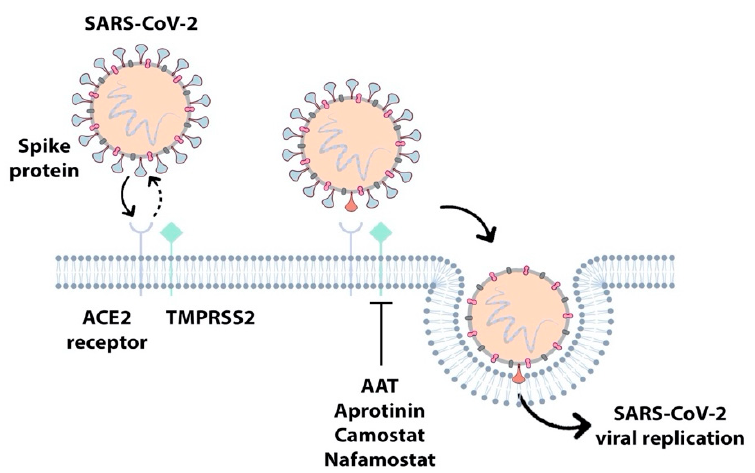
Figure 6. Host proteases are necessary for SARS-CoV-2 viral infectivity. SARS-CoV-2 uses the host angiotensin-converting enzyme 2 (ACE2) as an entry receptor. The TLP TMPRSS2 then cleaves and activates the spike protein of the virus, which mediates cell entry, viral replication and infectivity. A number of endogenous (AAT) and exogenous, large (aprotinin) and small molecule (camostat and nafamostat), inhibitors are capable of blocking viral host cell entry and represent possible therapeutic strategies for the treatment of COVID-19.